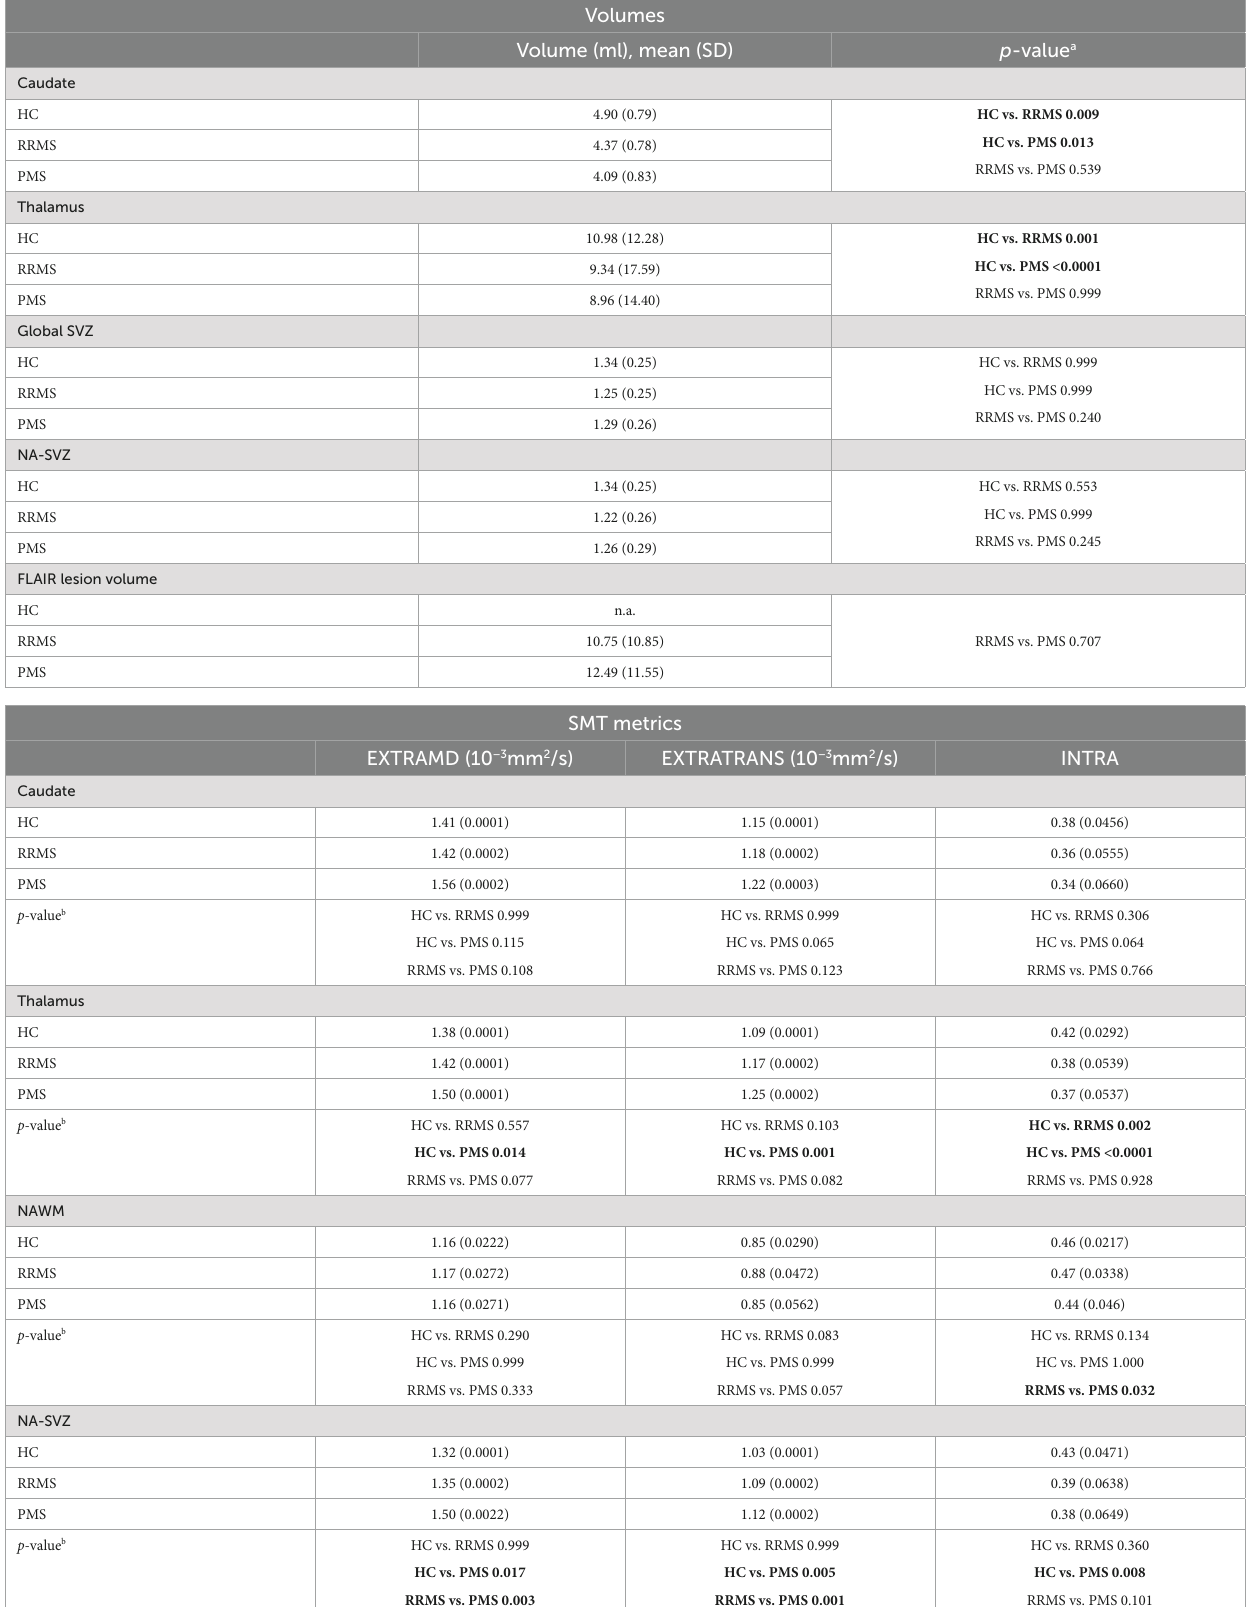
TABLE 2 Volumes and microstructural characteristics of SVZ, caudate and thalamus nuclei in HC, RRMS, and PMS patients.